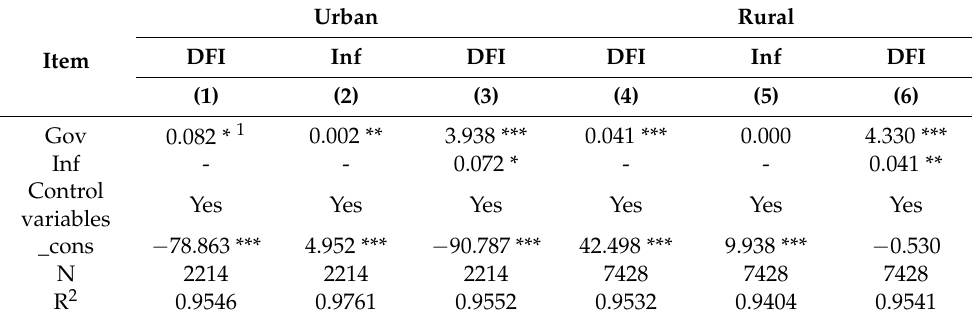
Table 7. Mechanisms analysis of governmental